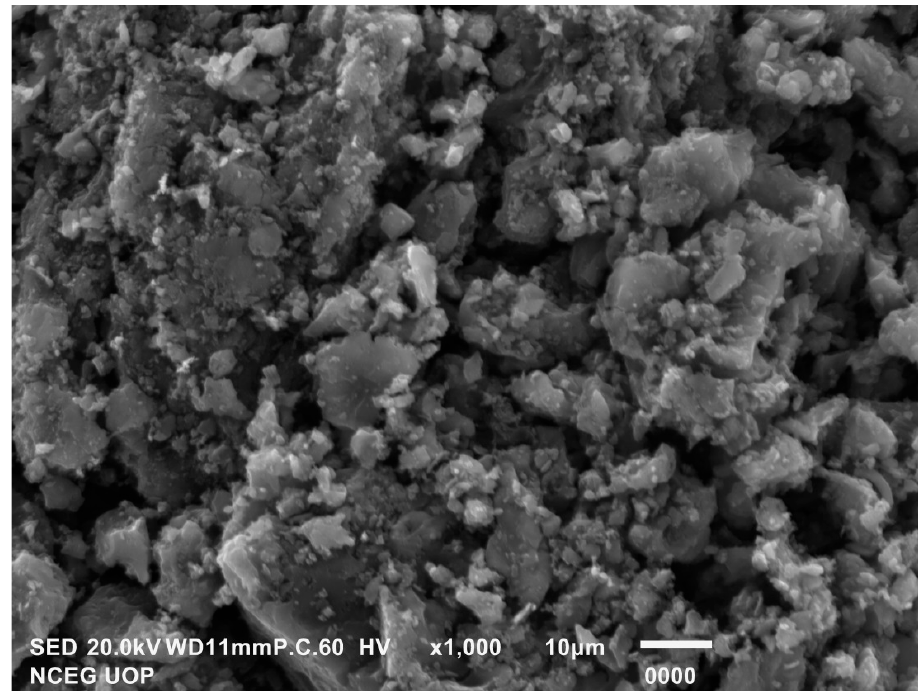
Figure 2. SEM of tea waste catalyst .